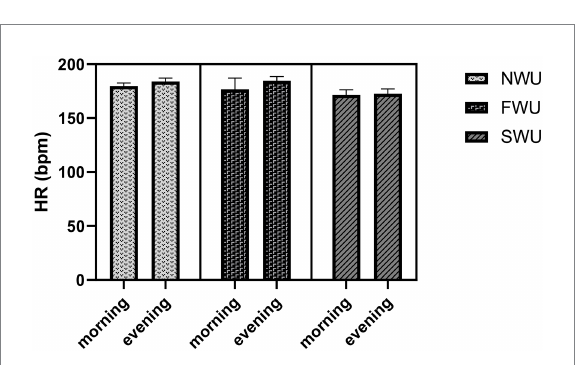
FIGURE 5 The heart rates of participants in the morning and evening hours for the three warm-up protocols. HR, Heart rate; NWU, No- warm-up; SWU, Specific warm up; FWU, Linear and Lateral warm